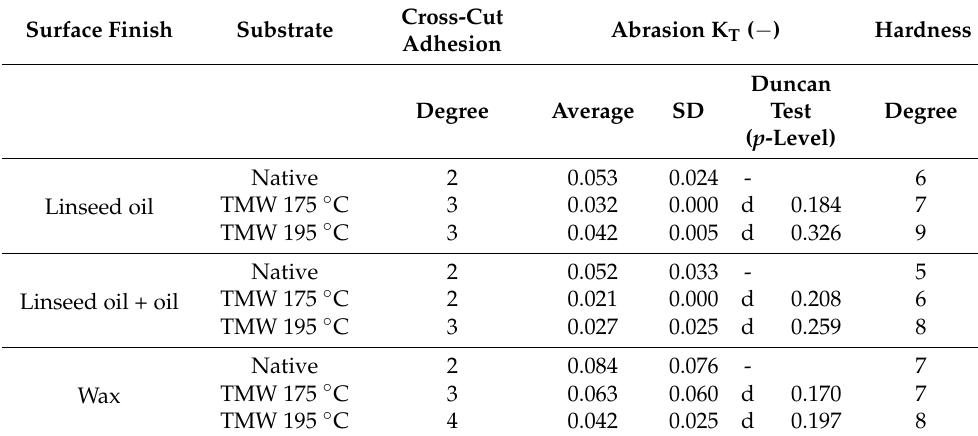
Table 8. Cross-cut adhesion, abrasion and hardness of the surface finish.